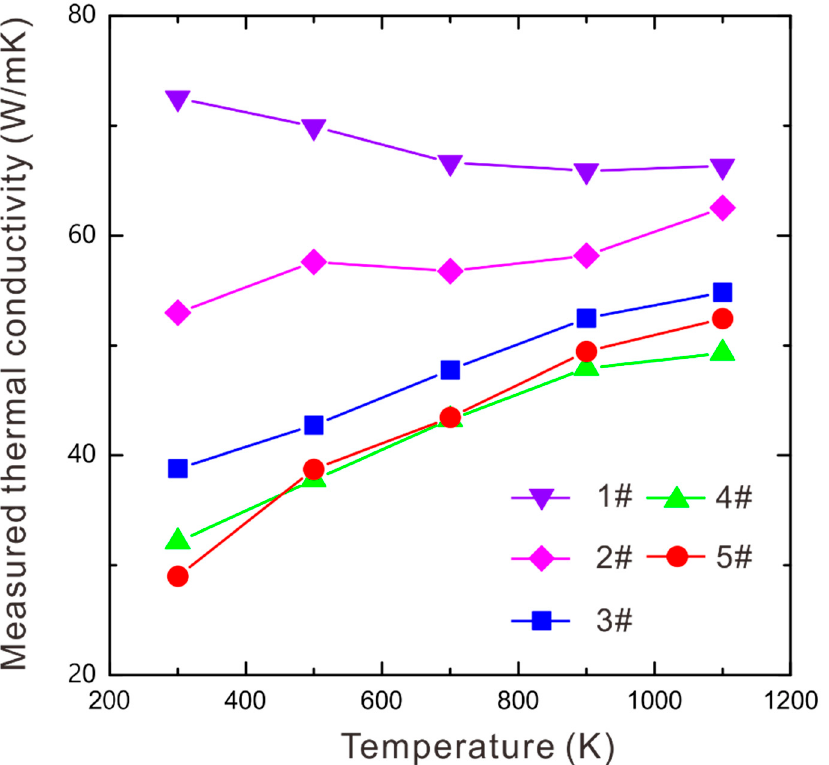
Figure 5. Temperature dependence of the measured thermal conductivity of the two-phase WC-Co-Ni samples prepared